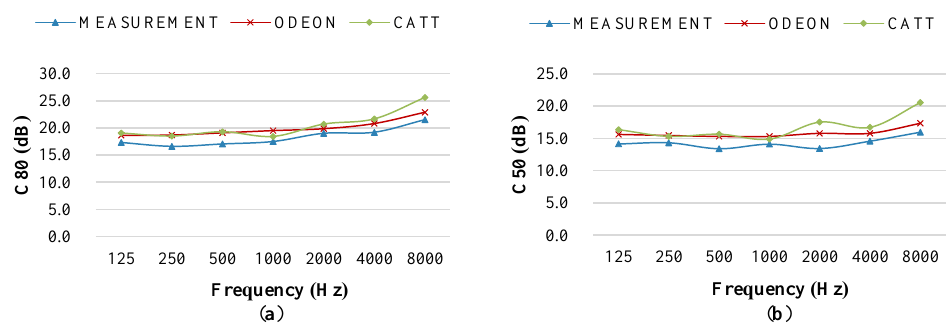
Figure 9. ( a ) Comparison of C80 in measurement and simulations with ODEON and CATT-Acoustic in source A. ( b ) Comparison of C50 in measurement and simulations with ODEON and CATT- Acoustic in source